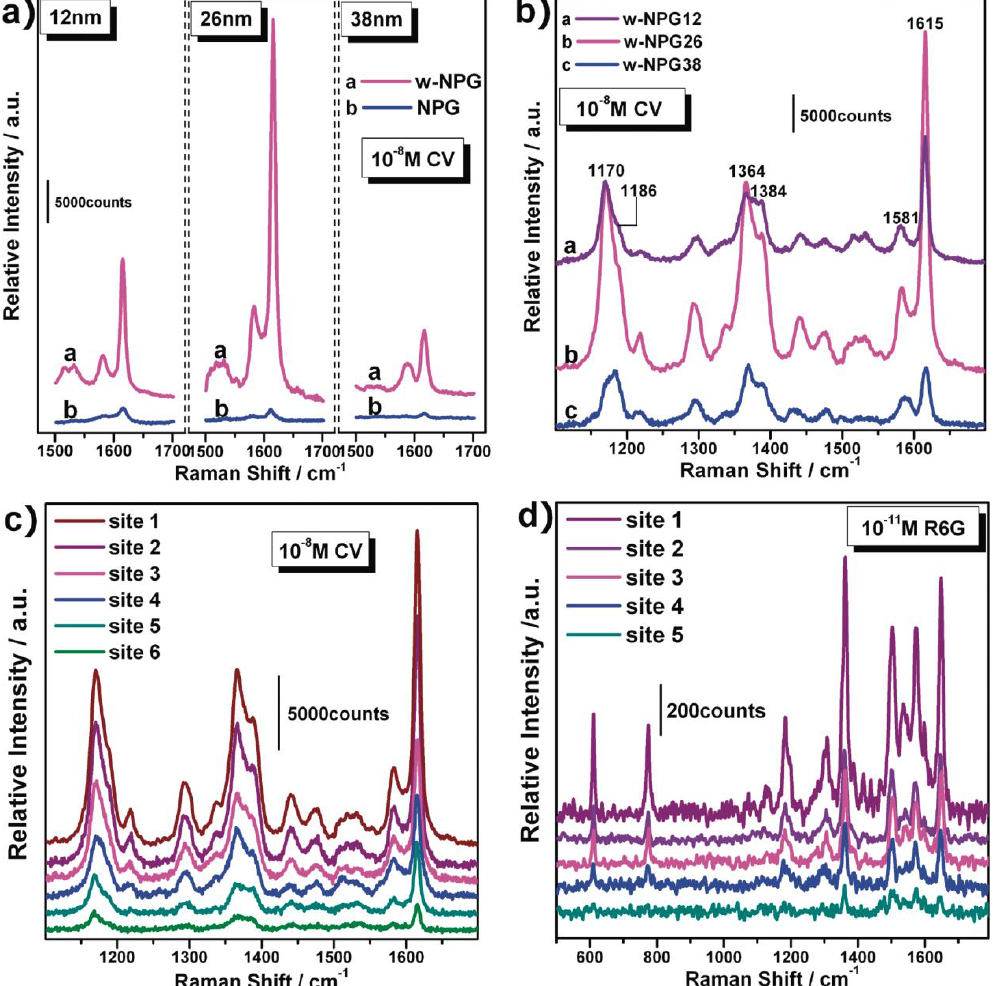
Figure 8. Surface enhanced Raman scattering (SERS) spectra of crystal violet (CV) and rhodamine 6G (R6G) molecules on wrinkled nanoporous gold (NPG)